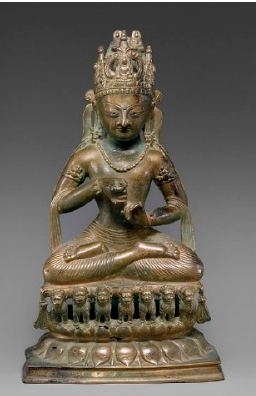
Figure 30. Vairocana in sambhogak ā ya form performing the bodhy ā gr ī mudr ā , ninth to early 10th c. From Pakistan (possibly Gilgit region). https://en.wikipedia.org/wiki/Gandharan_Buddhism#/media/ File:MET_DT5714.jpg.